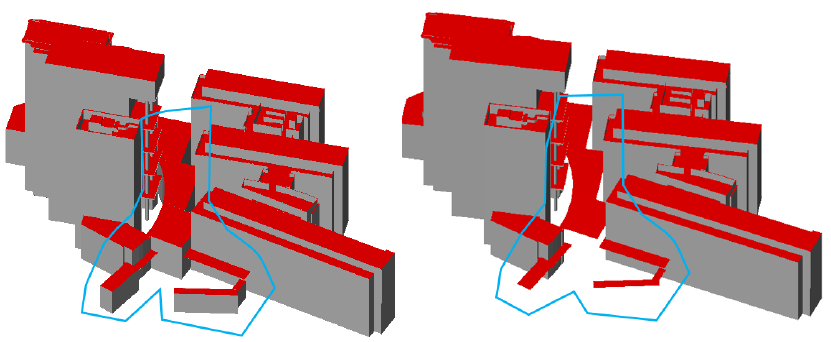
Figure 21. FZKViewer: Data model update after deletion. Roofs surfaces in red, wall surfaces in grey.